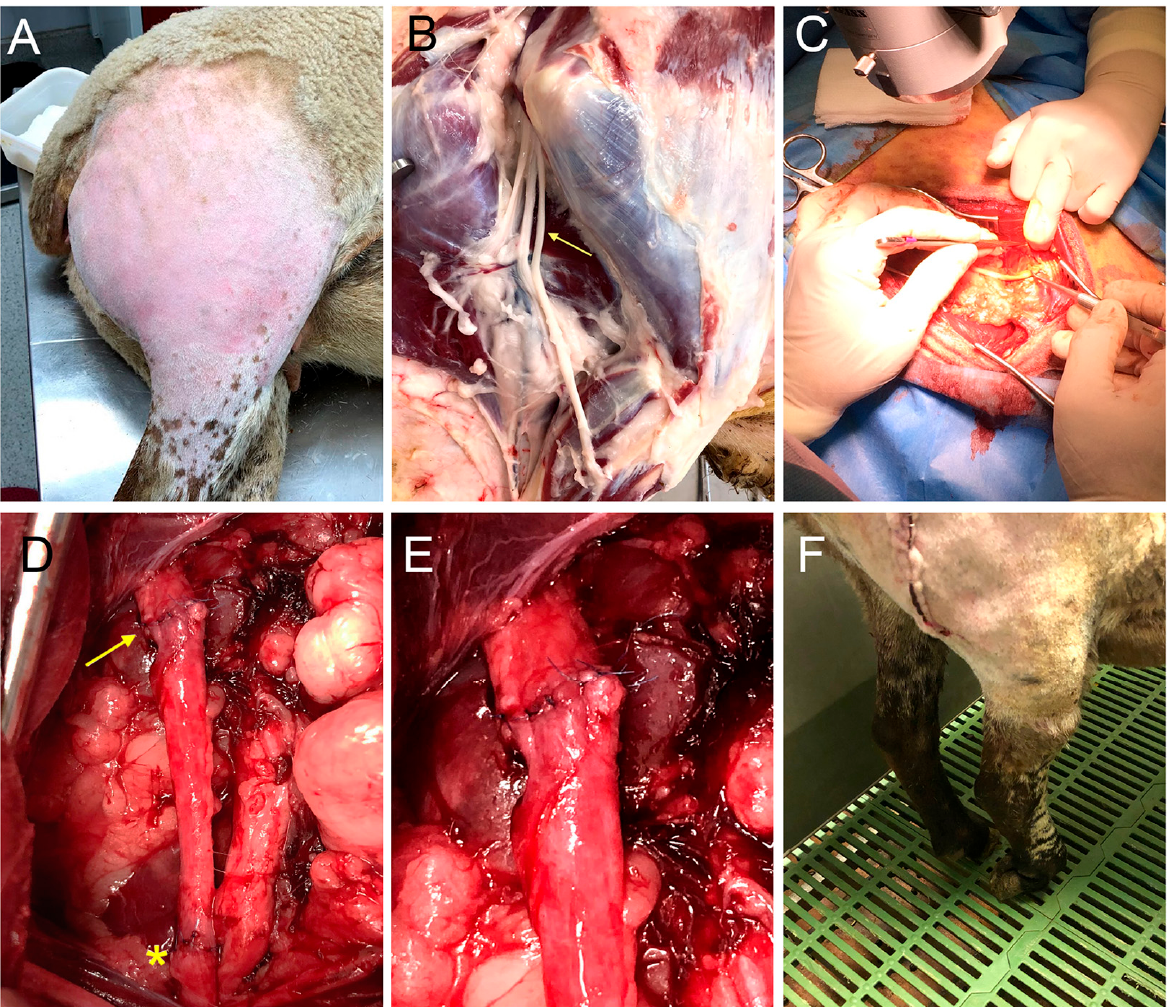
Figure 8. Photographs of the surgical procedure for the peroneal nerve injury and repair. ( A ) The surgical approach was performed with the animal in lateral recumbency through a lateral longitudinal skin incision. ( B ) Wide dissection showing the peroneal nerve location (arrow) after the sciatic nerve bifurcation into the tibial and peroneal nerve in a cadaveric sheep. ( C ) Resection of the common peroneal nerve under the operating microscope to create the nerve gap. ( D ) A 5 cm autograft was sutured again to the nerve stumps with epineural sutures (proximal suture marked with yellow arrow and distal suture marked with a yellow asterisk). ( E ) Detail of the 8 stitches made to join the nerve graft with the healthy nerve stump without tension. ( F ) After the surgery, some animals showed foot drop in the standing position.